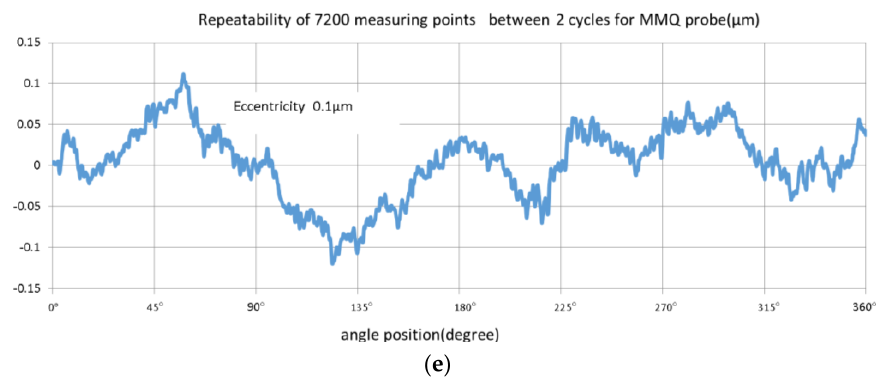
Figure 9. Centric measurement with MMQ400 Probe/T20w and capacitive sensor: ( a ) Capacitance sensor readings in two cycles; ( b ) Capacitance sensor value after nonlinear correction in two cycles; ( c ) MMQ400 probe reading in two cycles; ( d ) Repeatability of 7200 measuring points between two cycles for capacitive sensor after nonlinear correction; and ( e ) Repeatability of 7200 measuring points between two cycles for MMQ probe.